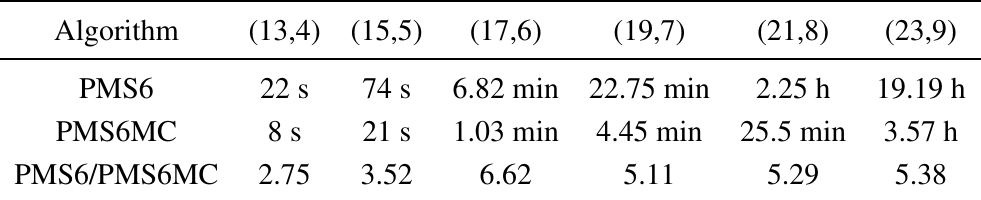
Table 2. Run times for PMS6 and PMS6MC.